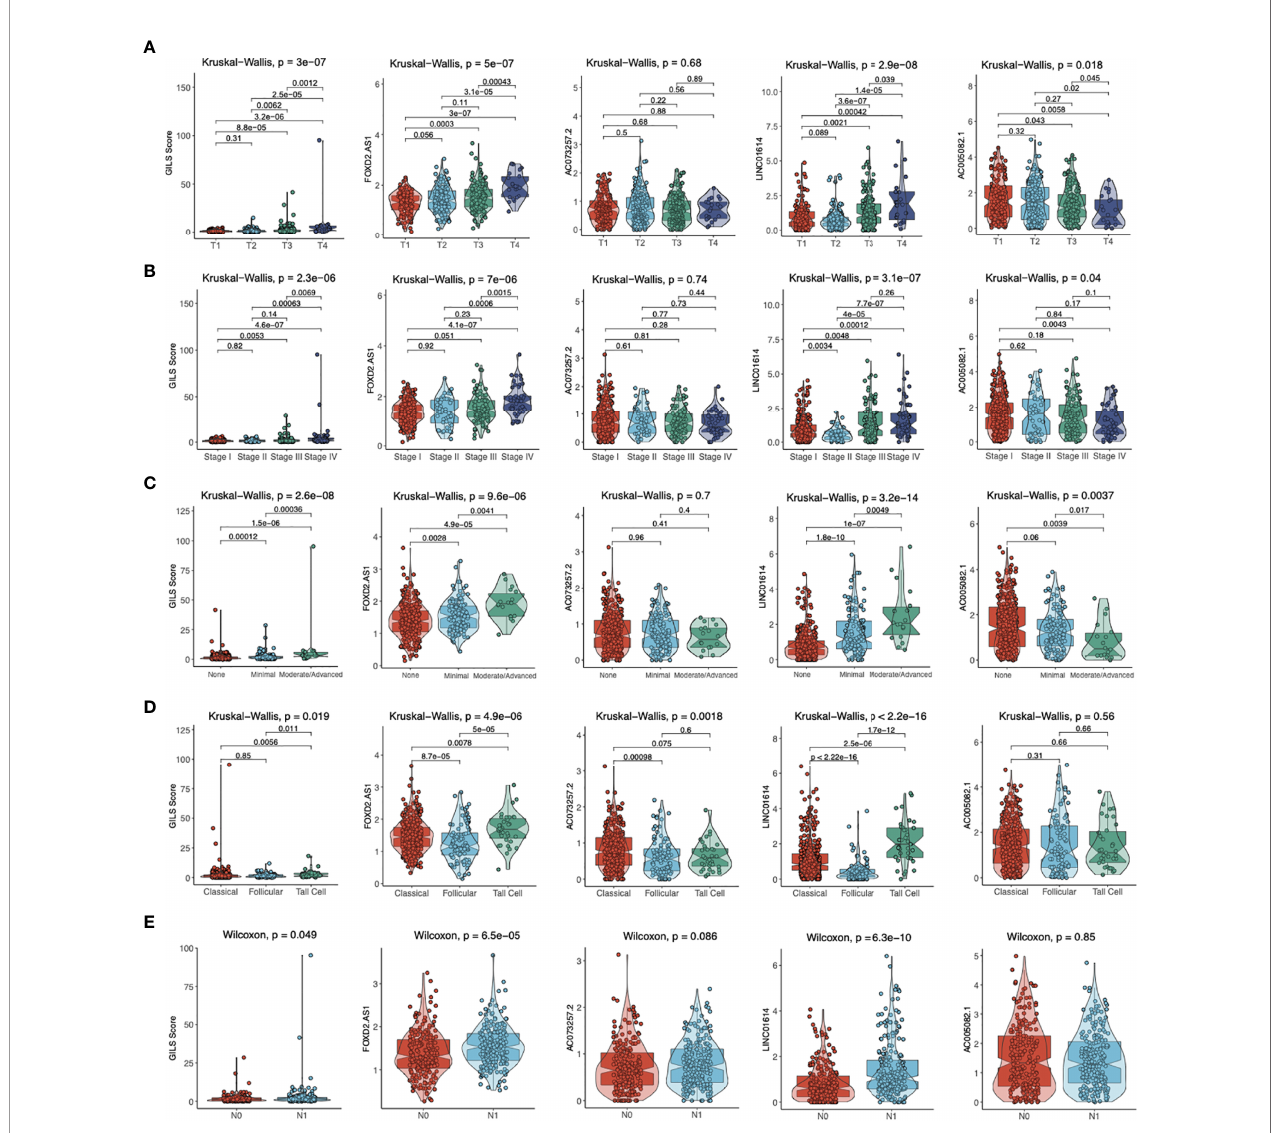
FIGURE 8 | The distribution of GILS scores in relation to clinical-pathological characteristics. The difference in GILS scores among (A) tumor stage, (B) pathological stage, (C) extrathyroidal extension, (D) histological types, and (E) lymph node metastasis subgroups as determined by the Kruskal-Wallis test or Wilcoxon test. The thick line represents the median value, and the scattered dots represent all score values. The bottom and top levels of the boxes display 25th and 75th percentiles,